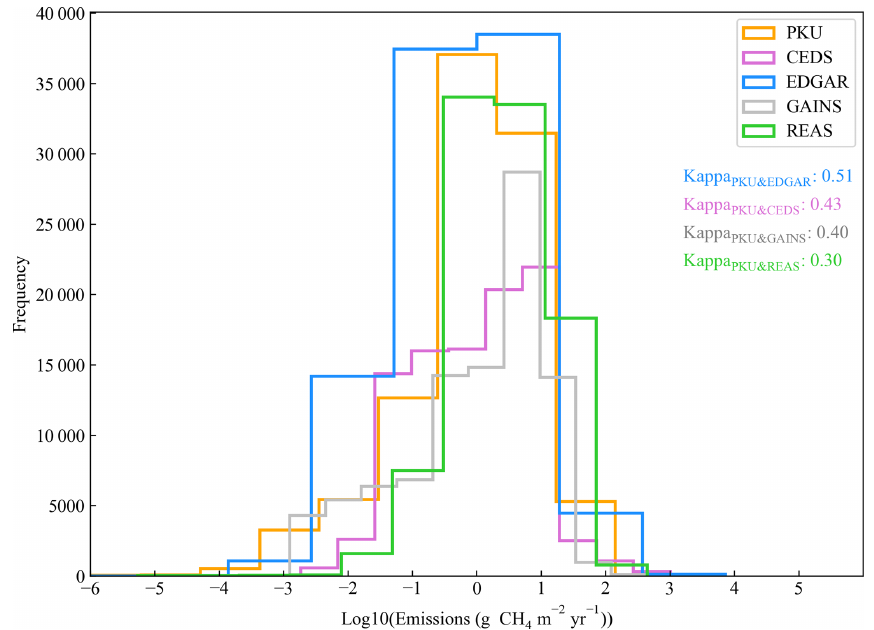
Figure 3. Frequency counts of emitting grids for PKU, CEDSv2017-05-18, EDGARv5.0, GAINS in 2010, and REAS in 2008. Kappa coefficients were calculated based on the quartile of